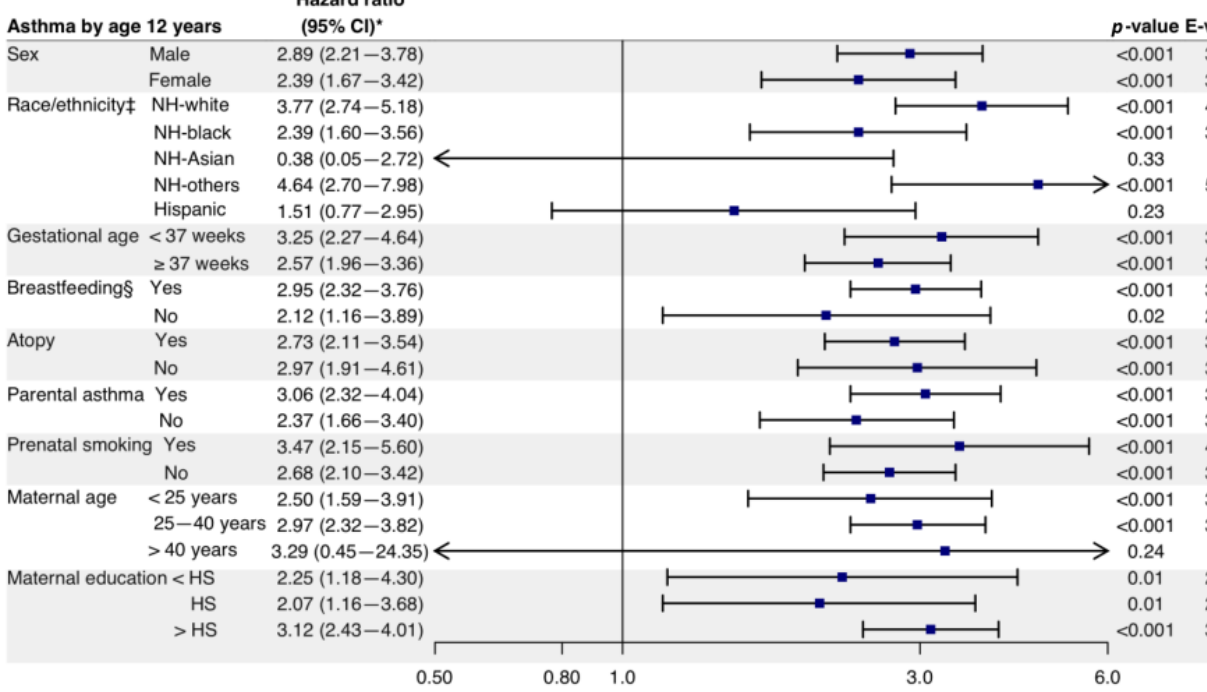
Figure 3. Effect of severe bronchiolitis on the development of asthma by major demographic and clinical factors. Arrows indicate that the 95% CI of the hazard ratio exceeds the lower or higher limit of the x-axis. * The Cox proportional hazard model was adjusted for 10 potential confounders (sex, race and ethnicity, calendar year of childbirth, gestational age, breastfeeding, child’s atopy, parental asthma, prenatal smoking, maternal age, and maternal education, except for the stratifying covariate), accounting for patient clustering by cohort. † The E-value (with its lower 95% CI bound) represents how strongly unmeasured confounder(s) would have to be associated with the exposure and outcome in order for the observed association to be independent. ‡ Test for the interactions between bronchiolitis hospitalization and demographic factors on the development of asthma: P interaction = 0.02 for race and ethnicity. § Test for the interactions between bronchiolitis hospitalization and demographic factors on the development of asthma: P interaction = 0.07 for breastfeeding. The p -values for the interactions of the other demographic factors were >0.10 and are listed in Table S3. Abbreviations: CI, confidence interval; HS, high school; NH, non-Hispanic.